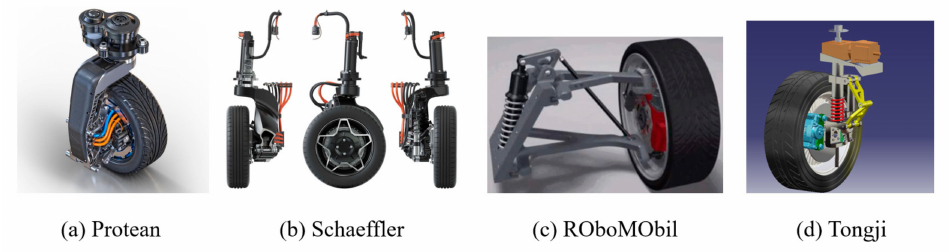
Figure 3. Integrated X-by-wire module for 4WID-4WIS